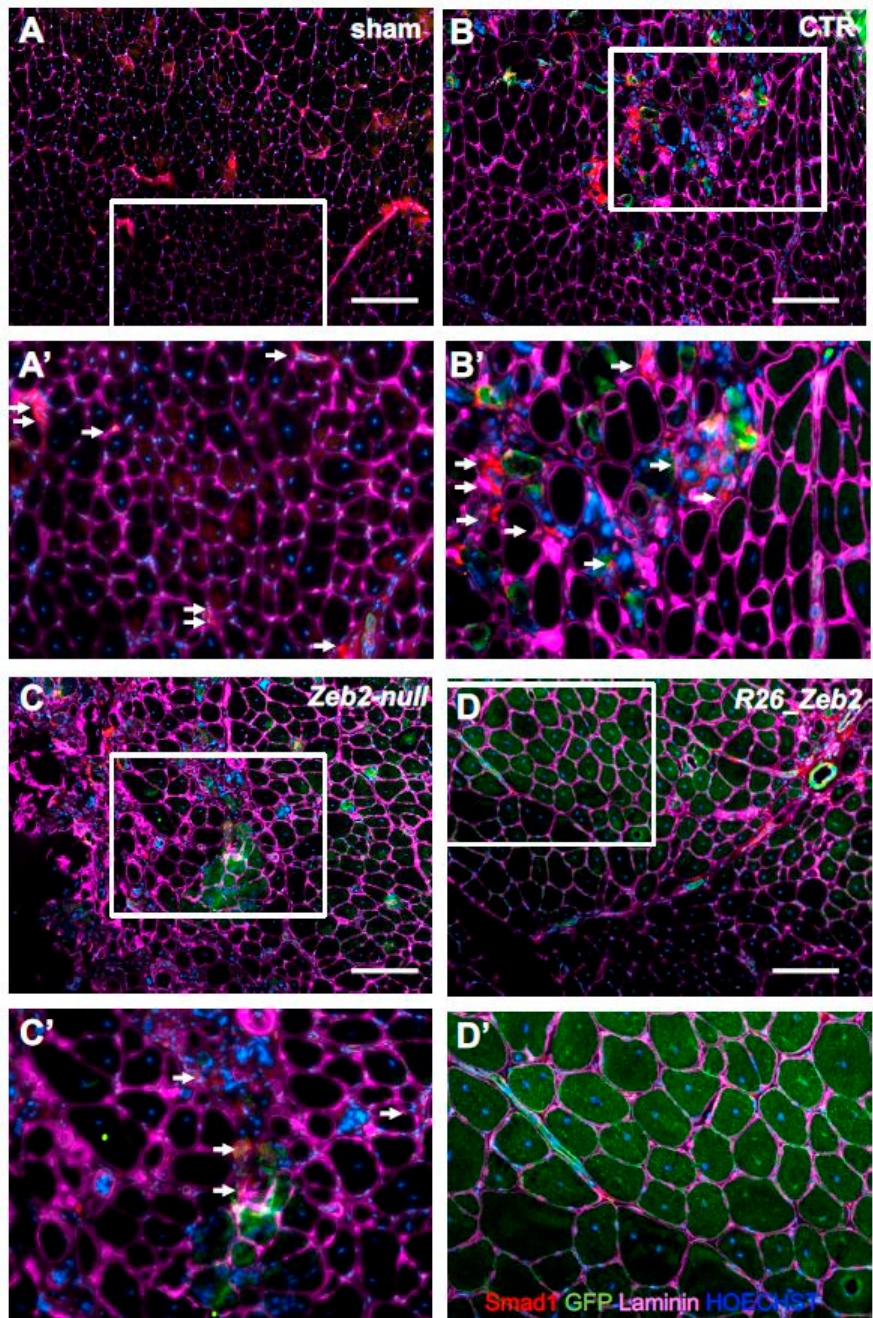
Figure 5. Smad1 + cells in muscles injected with Zeb2-null and R26_Zeb2 mESC derivatives. Immunofluorescence analysis of Smad1 (red), GFP (green), and laminin (magenta) in sham-operated (( A ) and inset ( A’ )) muscles, or injected with CTR ( Zeb2 flox / flox as control) (( B ) and inset ( B’ )), Zeb2-null (( C ) and inset ( C’ )), and R26_Zeb2 (( D ) and inset ( D’ )) GFP + mESC derivatives. Arrows indicate Smad1 + nuclei. Nuclei were stained in blue with Hoechst; scale bars = 200 µm.